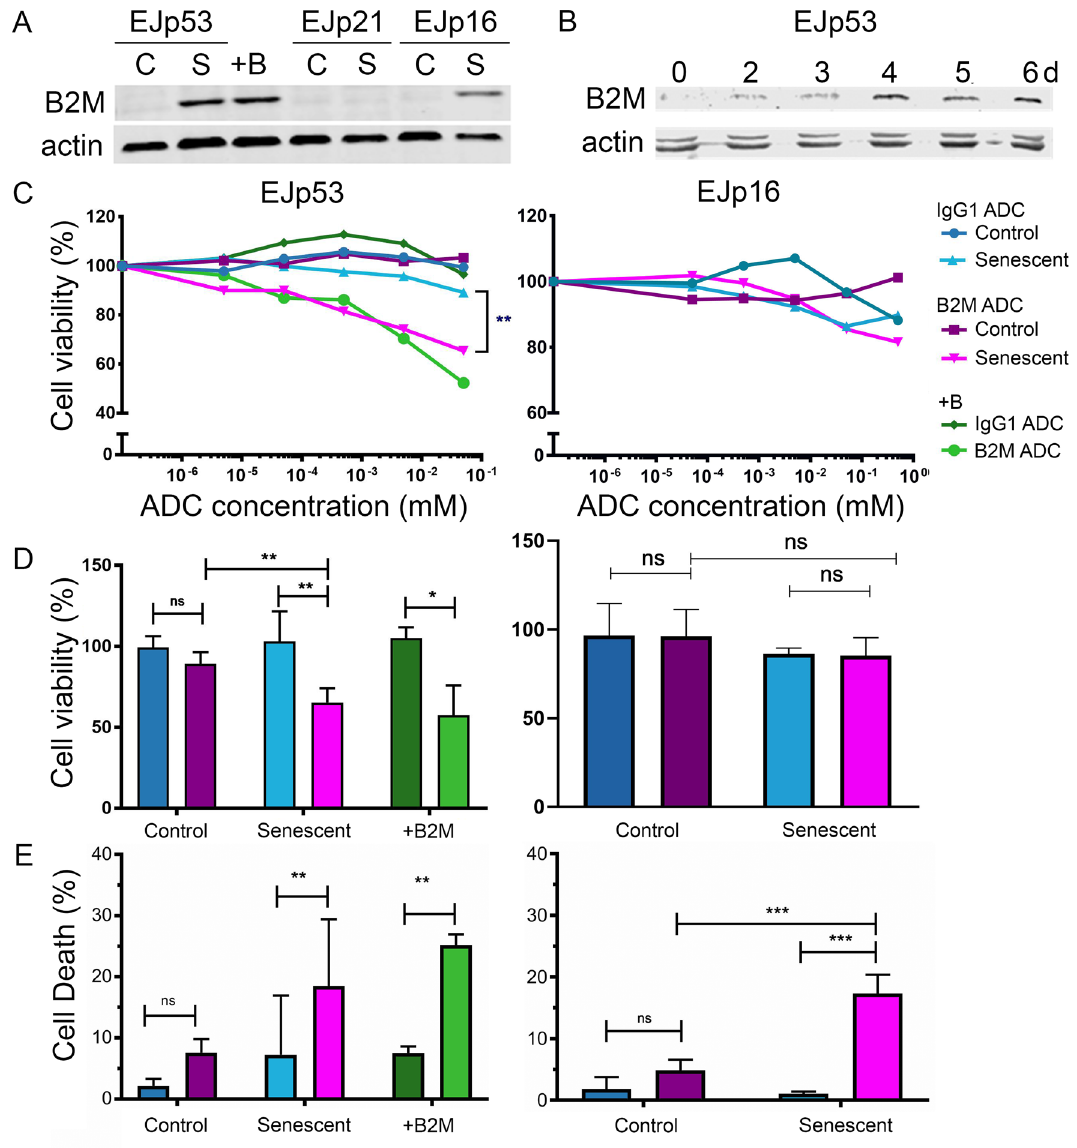
Figure 3. A B2M-duocarmycin ADC selectively kills senescent cells. ( A ) Representative Western Blot of B2M expression in EJp53, EJp21, EJp16 and HT1080-p21-9 cells 4 days after induction of p53 or p16 respectively, compared to EJp53 cells transfected with B2M cDNA for 4 days (+ B) . ( B ) Western blot showing B2M expression for different periods of time (0–6 days) in EJp53 cells transfected with B2M cDNA. ( C–D ) Cell viability, as measured by Cell Titre Glo, of proliferating and senescent (4 days after induction) EJp53 and EJp16 cells, incubated with different concentrations (C) or only 0.05 μM (bottom) of the B2M ADC or an isotype control for 72 h. An EJp53 cell transfected with B2M for 4 days was used as a positive control (+ B). Line and bar charts show the mean of 4 independent experiments. Colour codes match all panels. Bar represent the mean ± SD. * p < 0.05, ** p < 0.005. ( E ) Cell death, as measured by PI staining, in the same cells as above. Graphs show percentage of PI positive cells (dead cells). Bars represent the mean ± SD. * p < 0.05, ** p < cell-based strategies have also been proposed 65 , there is still a need for more targeted approaches with higher specificity and efficacy that the current ones. A key limiting factor for this is the ability to identify senescent cells, due to the lack of markers that are specific and universal. To address this issue, we screened for membrane proteins upregulated during senescence that have extracellular epitopes, and validated a series of novel markers in what was the first characterization of the senescent surfaceome 44 . Since then, the surfaceome has emerged as a potential source of targets for senolysis and senostasis 66 . Here, we tested ADCs as a strategy that takes advantage of the senescent surfaceome to specifi- cally deliver toxic payloads into senescent cells. Although this is a novel approach to clearing senescent cells, a similar idea has already been developed and validated in the treatment of cancer 53 , which suggests that this form of targeted senolysis could potentially be useful and could shorten the time needed to reach clinical trials.